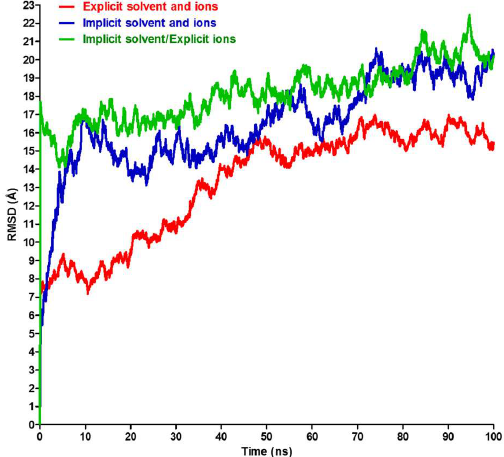
Figure 3. Total RMSD analysis of the entire antibody. The RMSD of the entire antibody (with all four chains included) for the three simulations described in the text. chains included) for the three simulations described in the